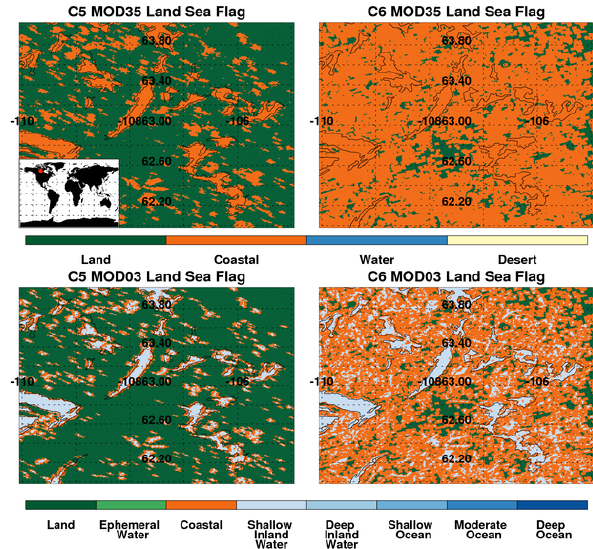
Figure 4: Illustration of differences between C5 and C6 inputs of Land/Sea Flag, from a small region in northern Canada.